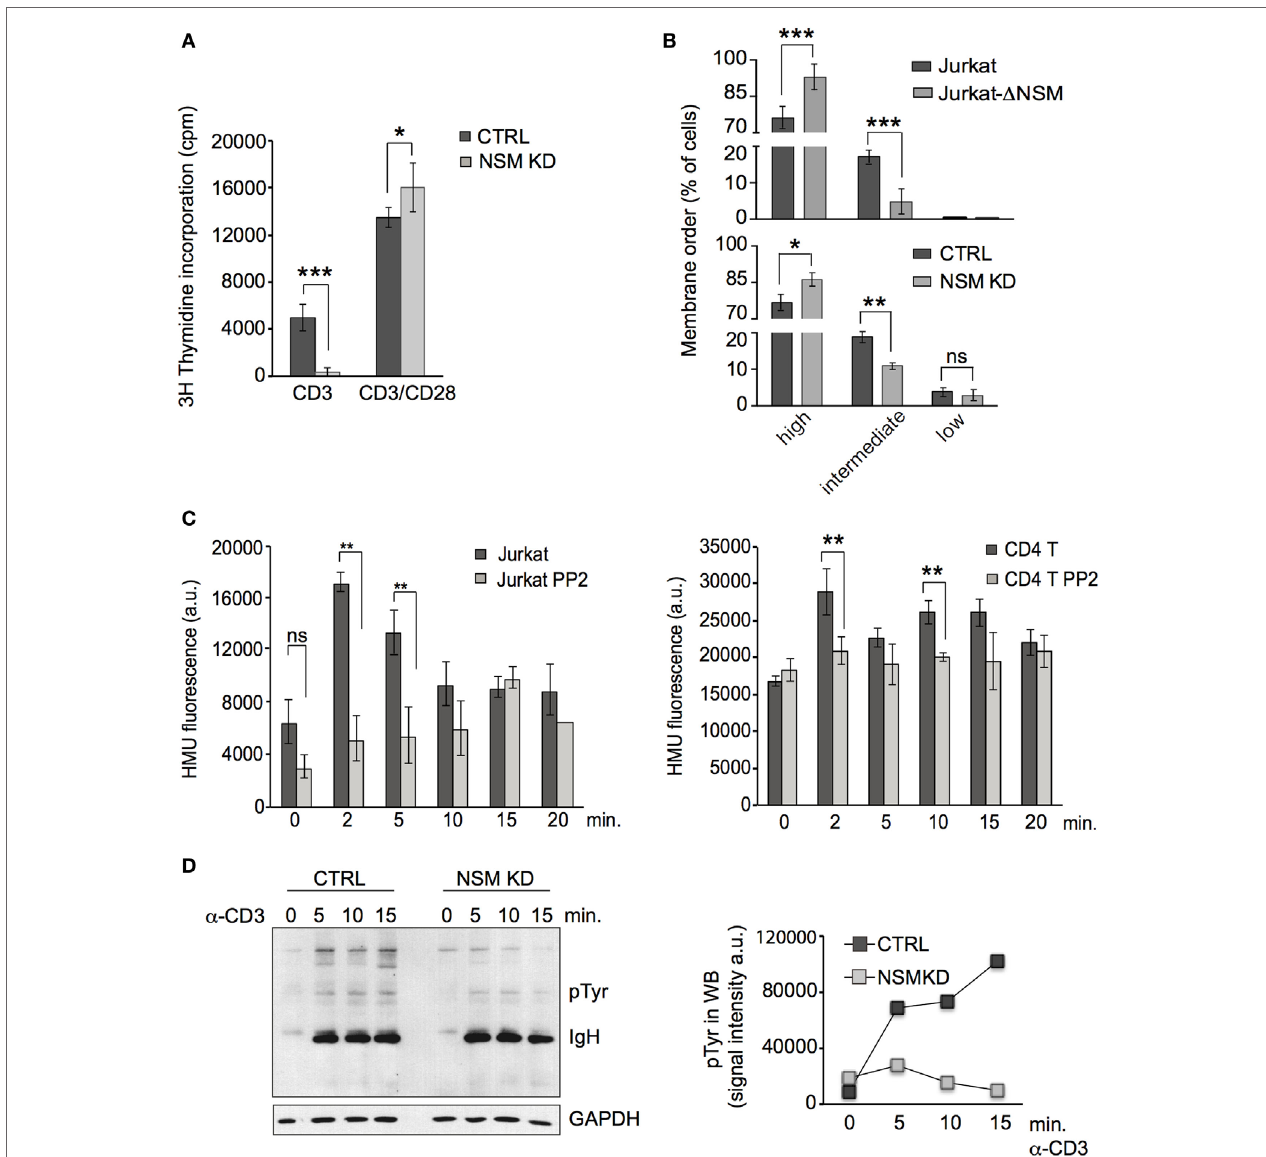
FigUre 1 | NSM activity is important in T cell receptor signaling. (a) CTRL (black bars) and NSM KD cells (gray bars) were stimulated by ligation of α -CD3 alone or in combination with α -CD28 (1 µg/ml each) and 3 H-thymidine incorporation was determined after 72 h. If not stated otherwise, data were obtained and statistically analyzed from at least three independent experiments with SDs indicated. (B) CTRL and NSM KD or parental Jurkat and Jurkat- Δ -NSM cells were stained with ANE and fluorescence emission at 570 and 630 nm and thereby cell populations revealing high, medium, and low lipid order were distinguished. (c) NSM activity was determined in α -CD3-ligated Jurkat (left panel) or primary CD4 + T cells (right panel) pretreated with PP2A (each gray bars) or not (each black bars) over time. (D) Accumulation levels of pTyr protein species were determined in α -CD3-activated (1 µg/ml) CTRL and NSM KD cells over time (right: densitometry quantification of the lanes shown in the blot, left panel). One out of three independent experiments is